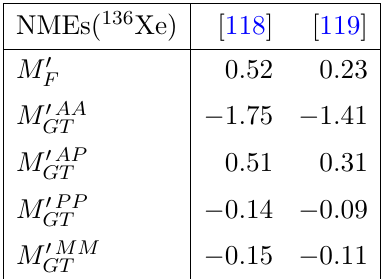
in the quasi-particle i